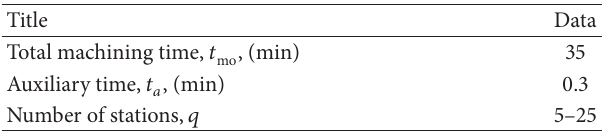
Table 1: Technical data of a serial automated line.